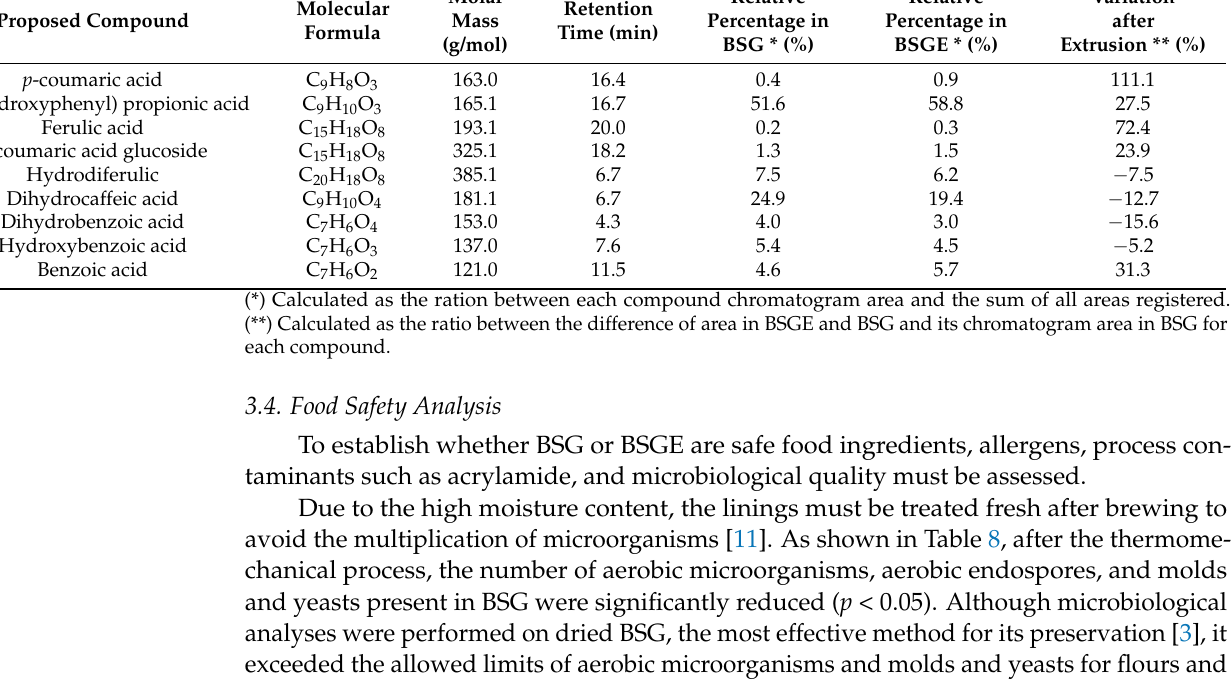
Table 7. Qualitative analysis of phenolic compounds present in BSG and BSGE. Proposed